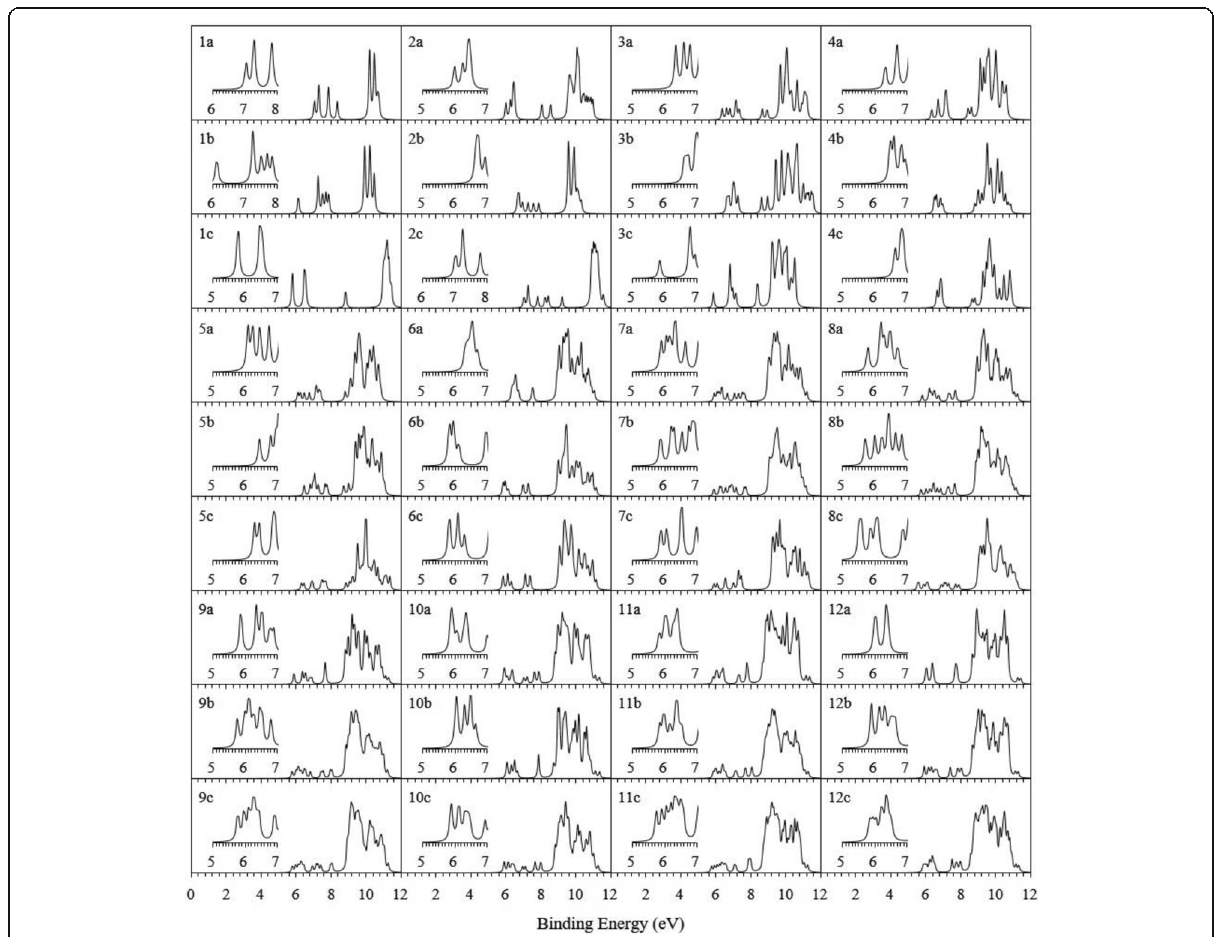
Fig. 4 Simulated PES of the ground state and two low-lying isomers of Ag n V ( n = 1 – 12) clusters